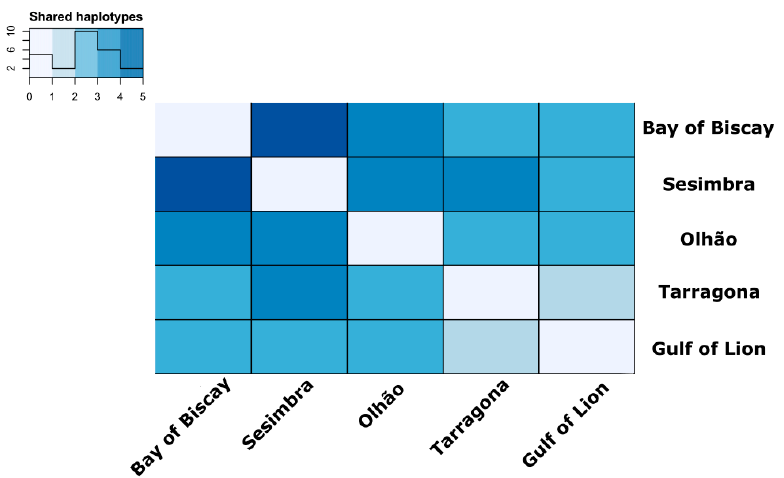
Figure 2. Heatmap of shared haplotypes. Quantification of the number of haplotypes shared by sampling locations. The legend refers to absolute numbers shared among locations, with the histogram line representing the frequency distribution.